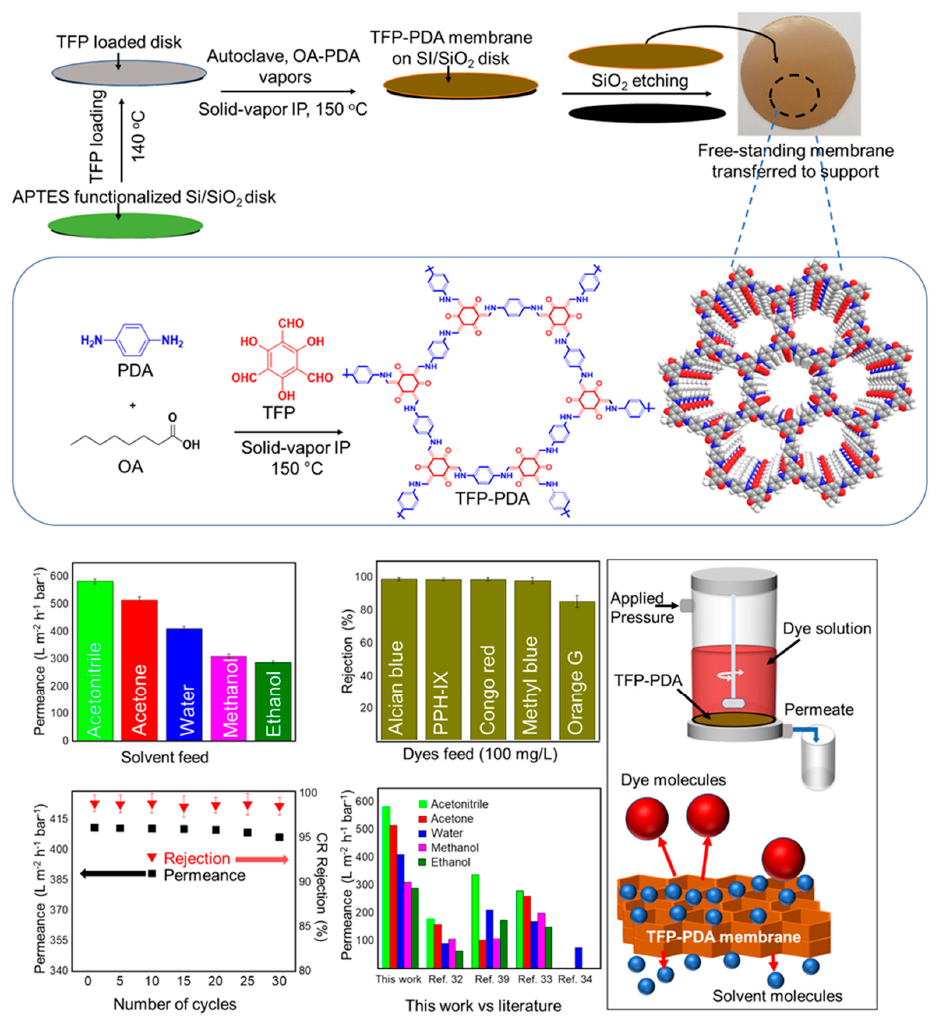
Figure 7. Employment of solid-vapor interface for the fabrication of COF membranes. Adapted with permission from reference [75] copyright 2020 American Chemical Society.